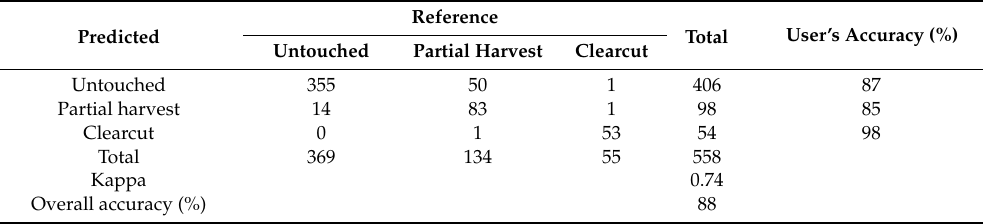
Table 8. Aggregated confusion matrix of forestry activity classifications for the four